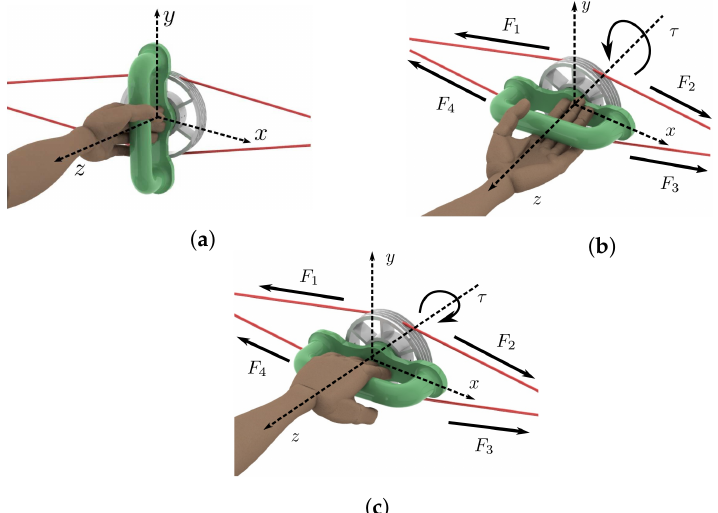
Figure 5. Left wrist–forearm. ( a ) Neutral position. ( b ) Supination. ( c )